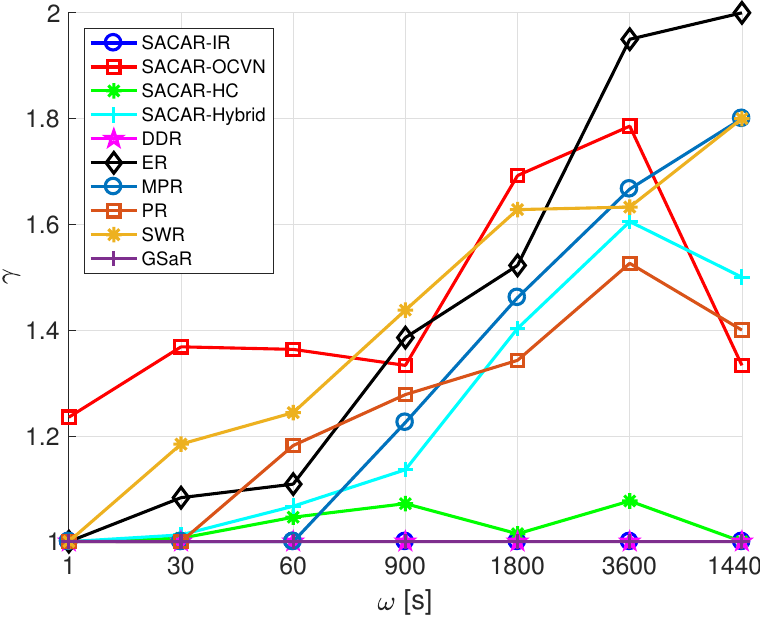
Figure 11. Average number of hops ( γ ) vs. frequency of message generation ( ω ): smart office